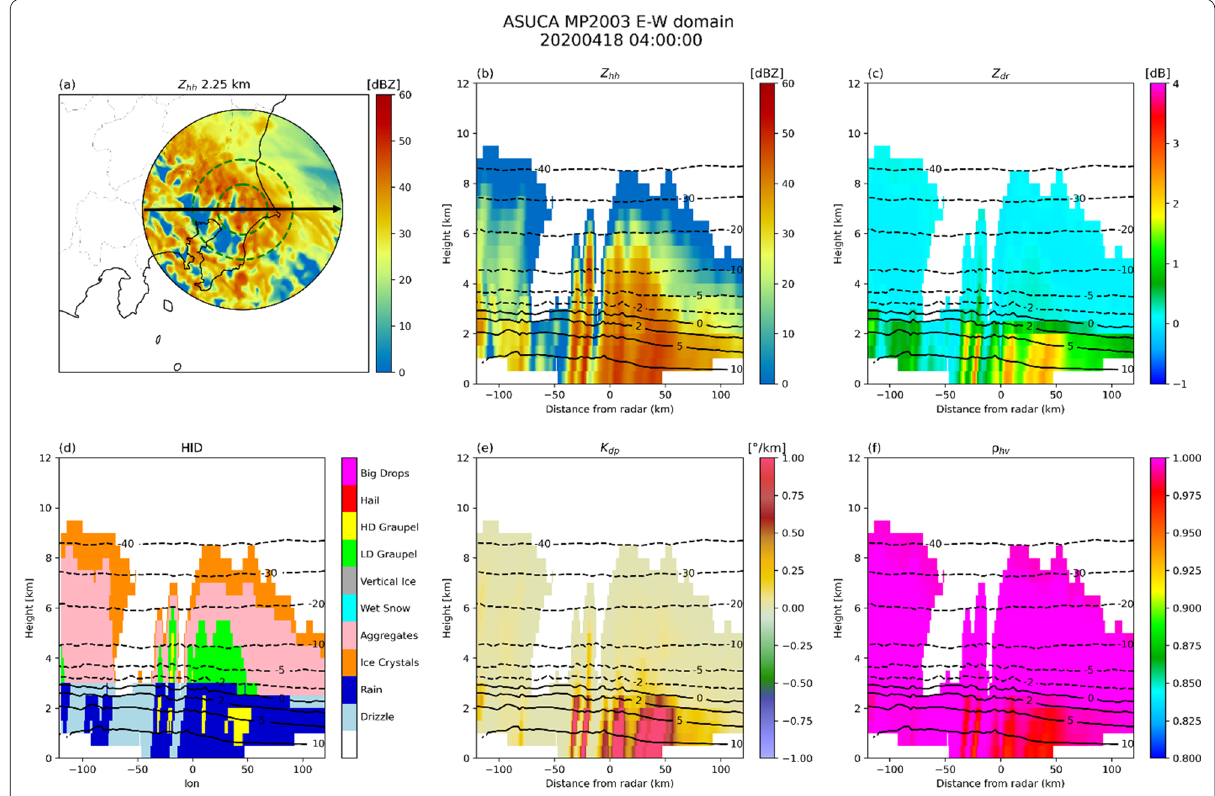
Fig. 9 The same as Fig. 6, but for the results of the ASUCA